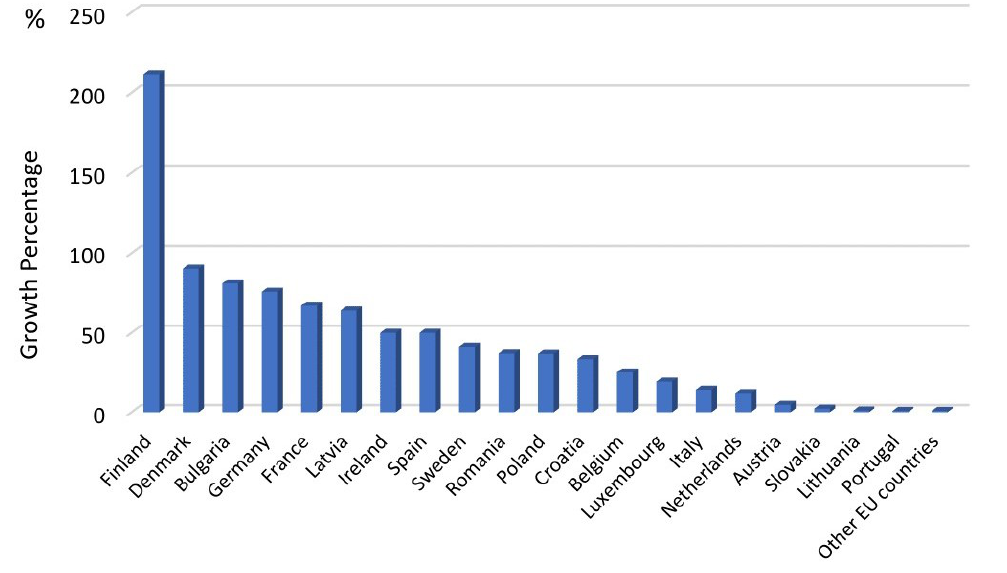
Figure 2. Growth percentage of battery electric buses in EU